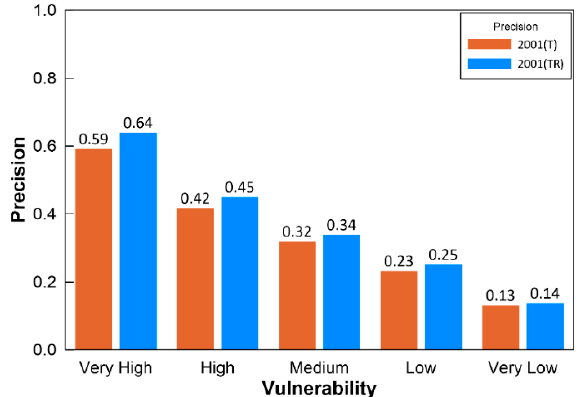
Figure 9. Proportion of flood occurrence in vulnerable areas. Figure 8. Proportion of flood occurrence in vulnerable areas.